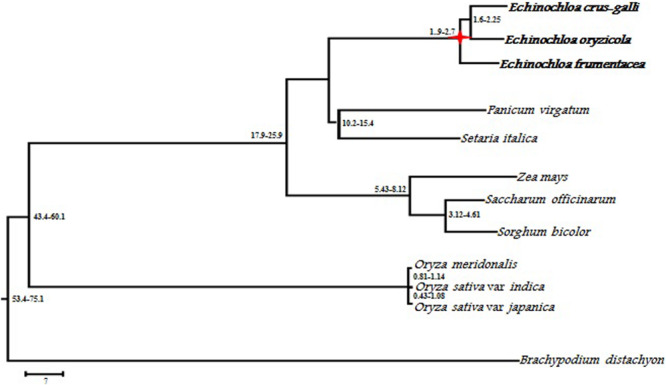
Phylogenetic tree showing relationships among Echinochloa species and grass species (from Perumal et al., 2016).